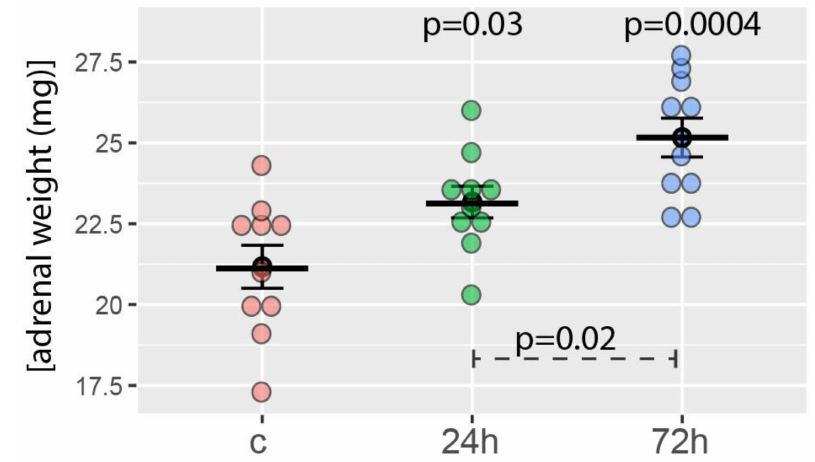
Figure 1. Right adrenal weight obtained from the control group (c, sham adrenalectomy, after 24 h) as well as from two experimental groups: right adrenals from 24 and 72 h after left unilateral adrenalectomy ( n = 10/experimental group). Mean, standard error of the mean, and p -values of the Student’s t -test are shown. The p -values located above the experimental groups refer to a comparison with control. The p -value over the dashed line refers to the comparison between experimental groups (24 vs. 72 h after left unilateral